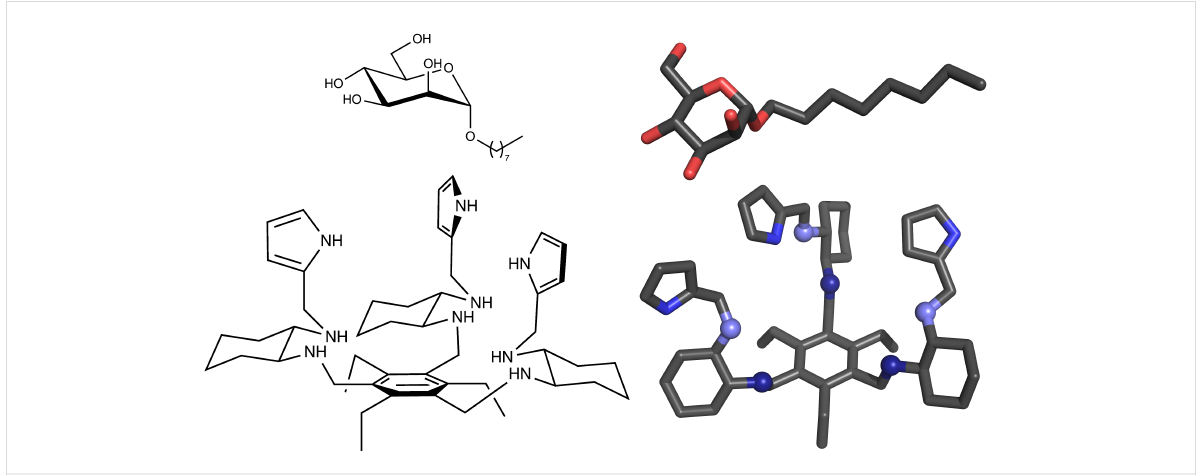
Figure 1: Octyl α -D-mannoside (mannoside) and diaminopyrrolic tripodal receptor molecules. 2D and 3D representations are shown. In 3D, all hydrogen atoms were omitted for clarity, and titrable amino groups are shown in spheres with first generation in dark blue and second in light blue.